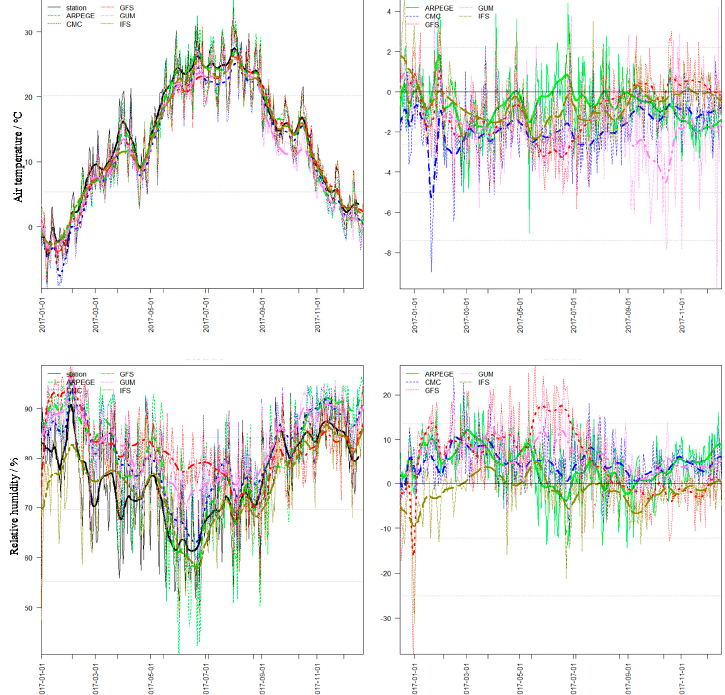
Figure 5. ( Top left ): maximum temperature (in °C) predicted by five meteorological models for 3 days ahead and reality (black) in the Czech Republic in the year 2017. ( Top right ): maximum temperature differences of the NPW outputs with regard to reference series (reality based on station data interpolated into maps). Thick lines: values smoothed with 30-day low-pass Gaussian filter. ( Bottom ): the same as above but for relative humidity (in %).